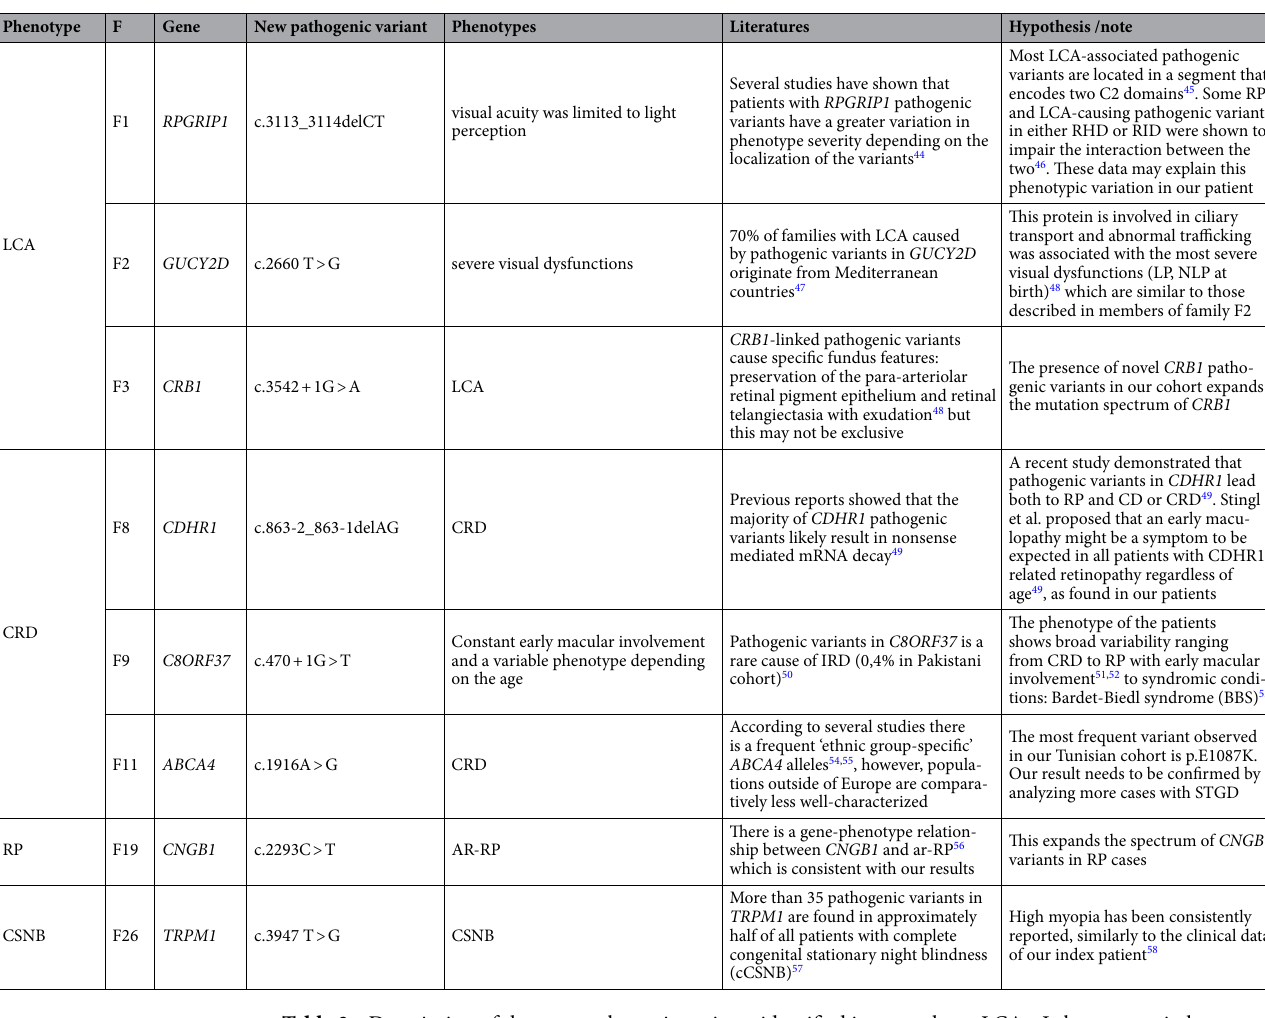
Table 3. Description of the new pathogenic variants identified in our cohort. LCA = Leber congenital amaurosis; CRD = cone rod dystrophy; RP = retinitis pigmentosa; CSNB = congenital stationary night